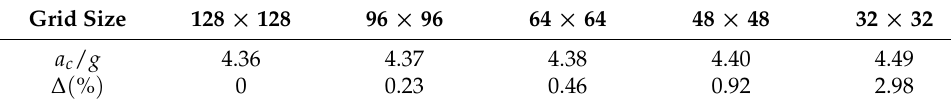
Table A3. Spacial grid size sensibility analysis of a c / g for FT S in the linear regime. Grid